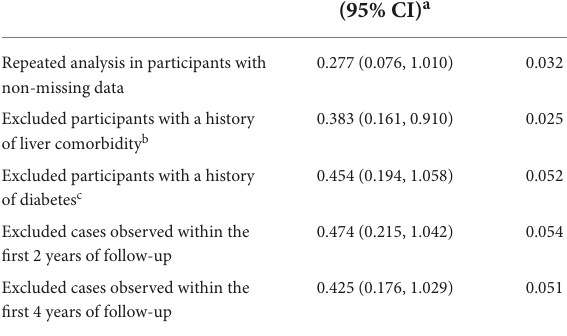
TABLE 3 Sensitivity analyses on the association of low-fat diet scores with the risk of liver cancer. Categories